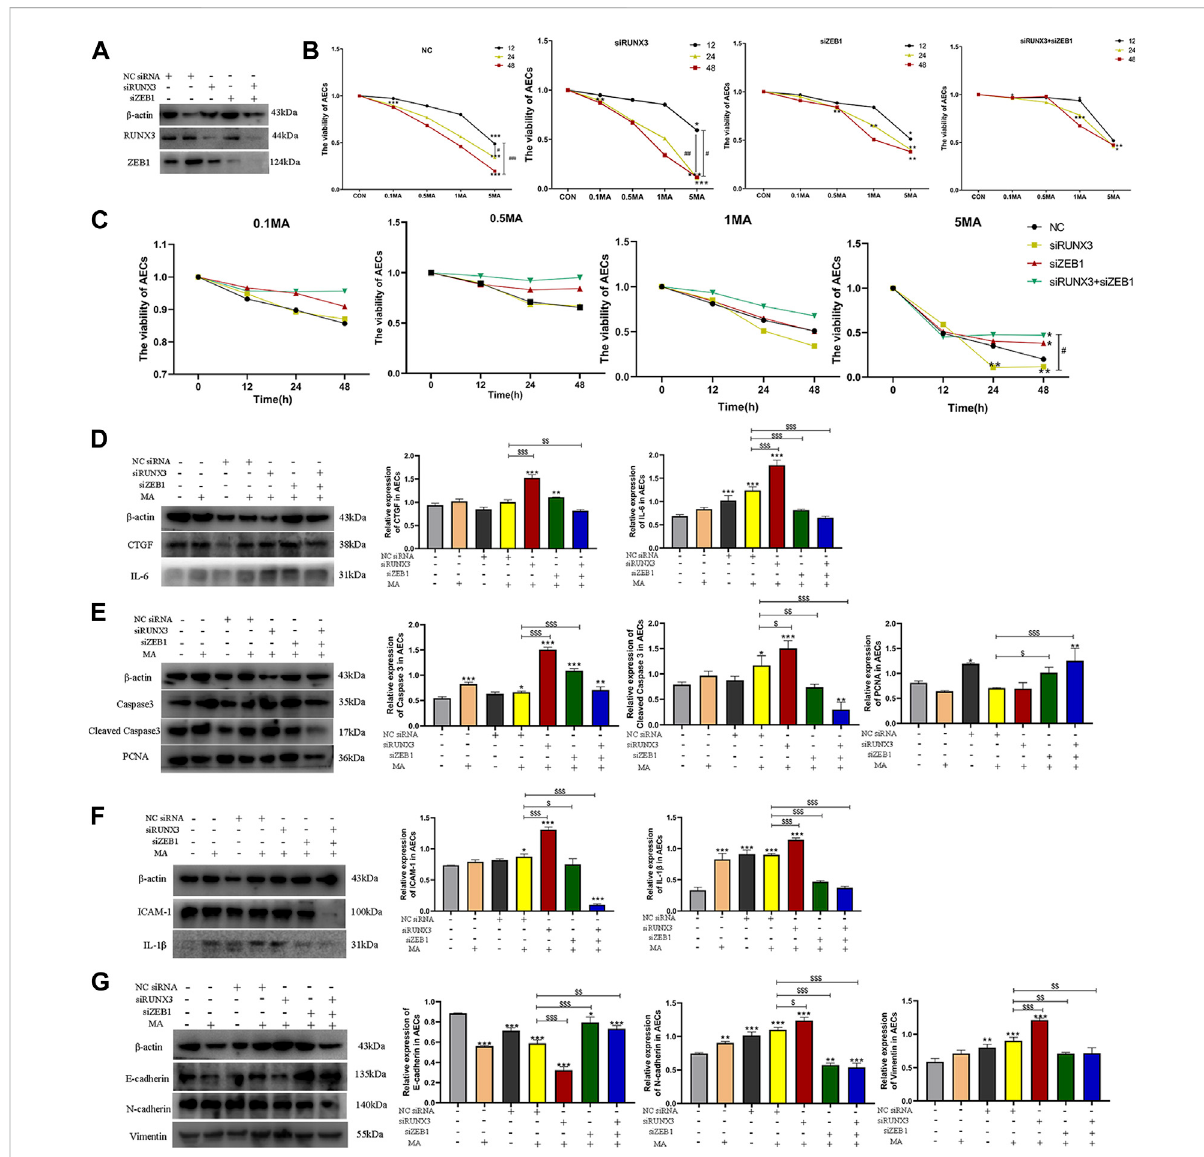
FIGURE 6 The interaction of RUNX3 with ZEB1 in MA-induced chronic lung injury. (A) The viability of AECs in different groups (NC, siRUNX3, siZEB1, siRUNX3+siZEB1) on MA exposure. (B) The viability of AECs on treatment with different dosages of MA. (C) Effects of MA exposure on RUNX3, ZEB1, CTGF, and IL-6 expression in AECs transfected with the corresponding siRNA. (D) Effects of MA exposure on caspase-3, cleaved caspase-3, and PCNAexpressioninAECstransfectedwithsiRNA. (E) Effects ofMA exposureonICAM-1 and IL-1 β expression inAECstransferredwithsiRNA.